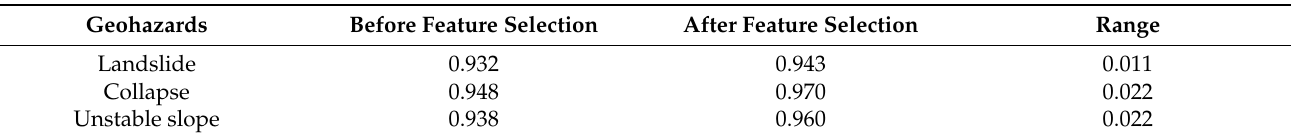
Table 11. Changes in AUC after using the filter-MDA feature selection method. The highest improve- ment appeared in the Collapse and Unstable slope datasets, up to 0.022.